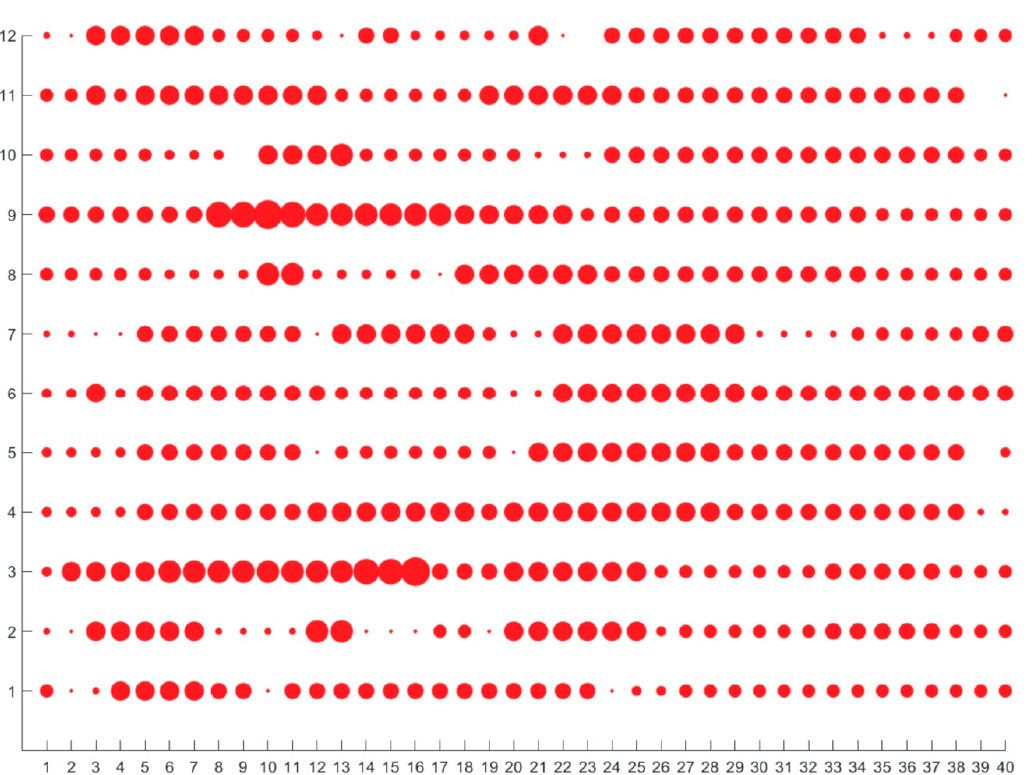
Figure 6. Spatiotemporal displacement of ToBRFV inside the greenhouse. The 12 × 40 grid shows the progression of controlled infections. Each round shows the viral infection intensity in the corresponding plant, located in the grid. No round means no infection. Conversely, the more extended the round, the longer the infection, with respect to the start of the induced infection. The most extended rounds represent the locations of the two infected plants that originated the induced infection (row No. 3 position 16 and row No. 9 position 10).